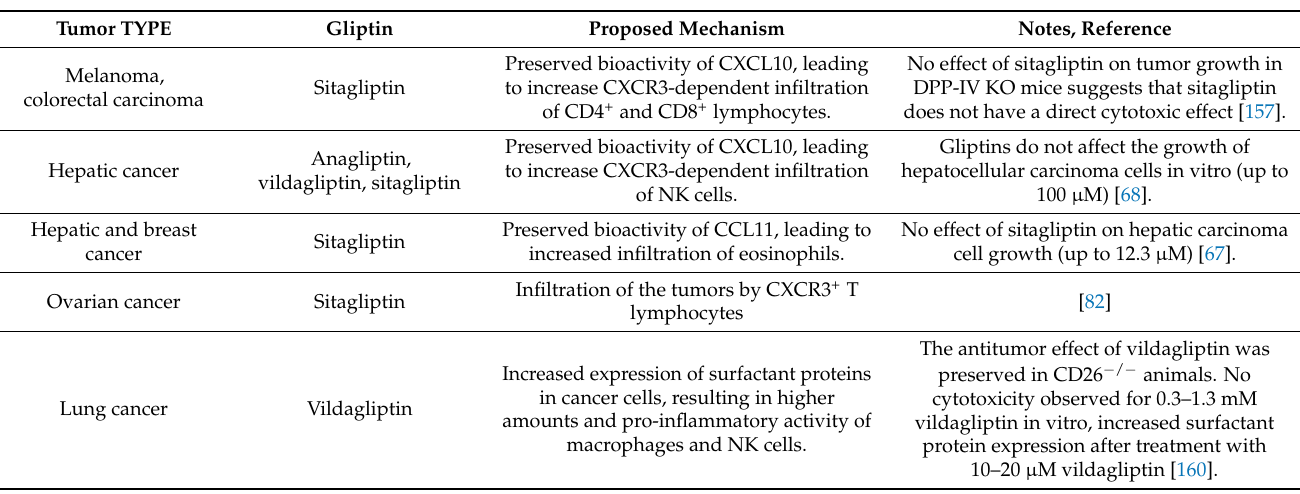
Table 5. Summary of studies suggesting antitumor effect of gliptins mediated by promotion of antitumor immune